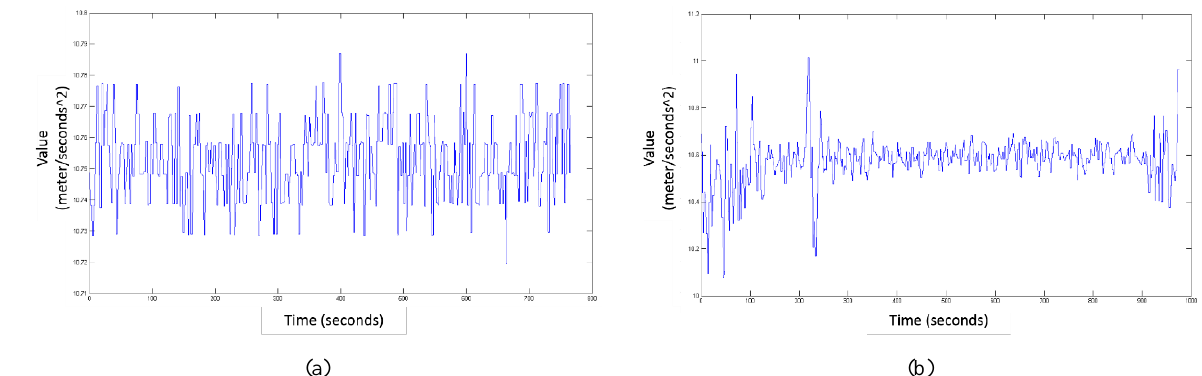
Figure 5. The plot of log file of (a) the smart phones lying on a table and (b) the smart phone being held in hand without walking